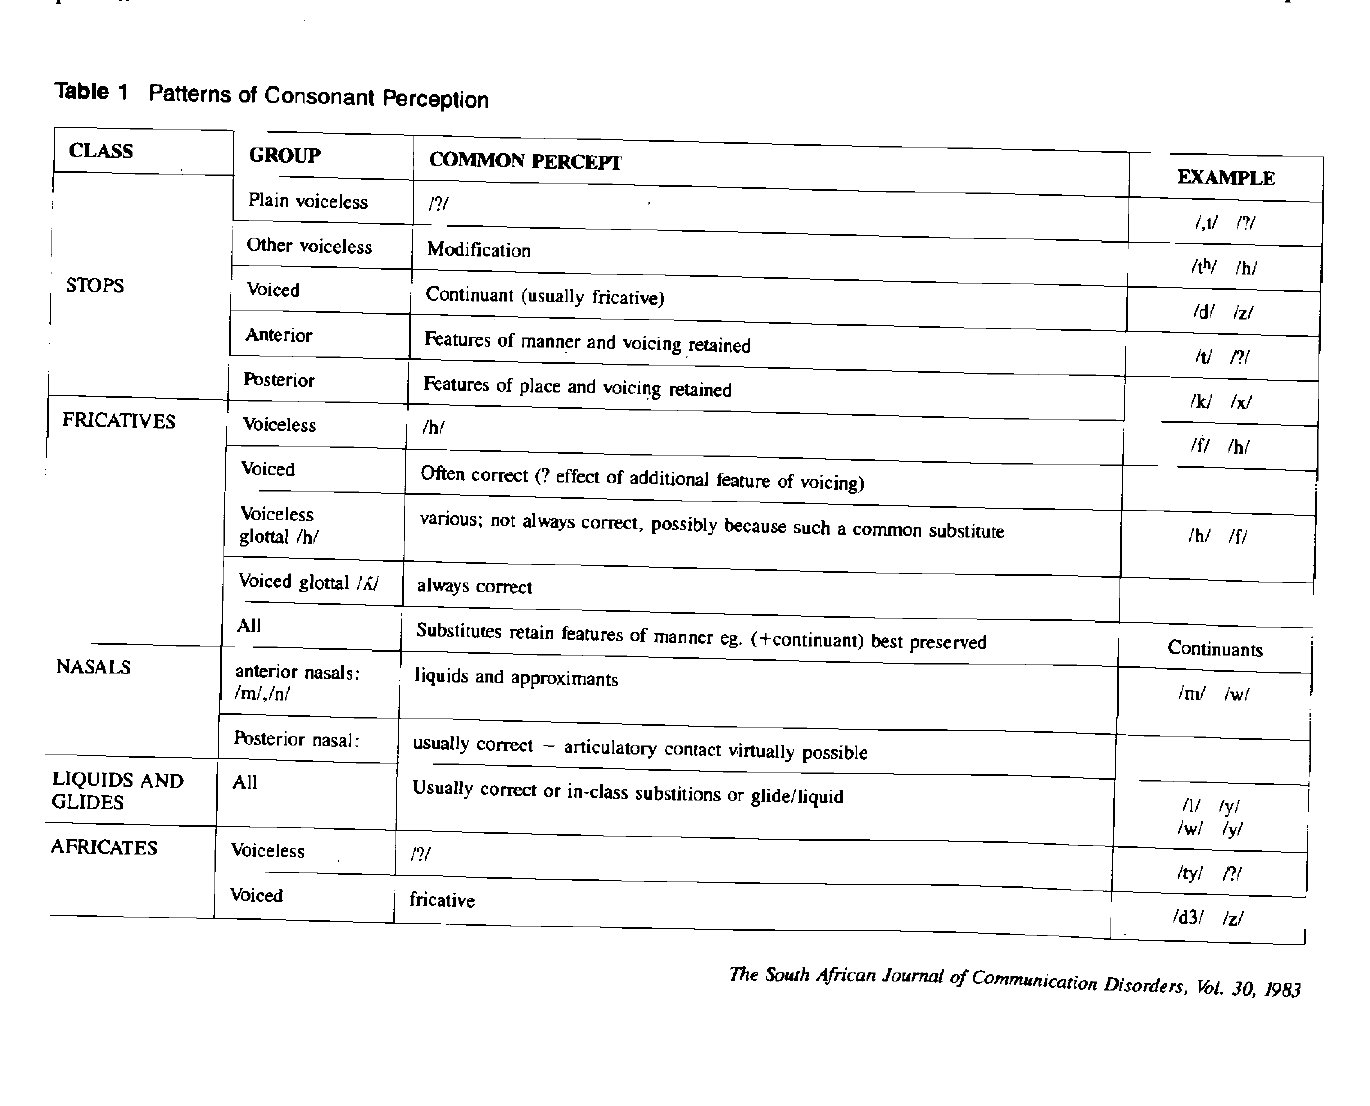
Table 1 Patterns of Consonant